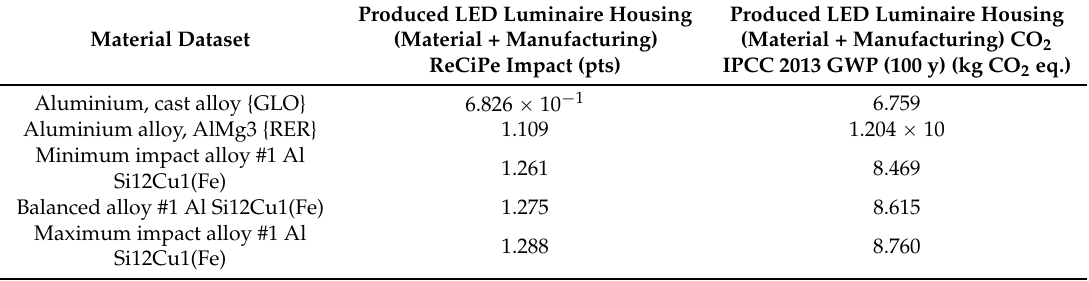
Table 11. Environmental impact of the material plus manufacturing process of an LED luminaire